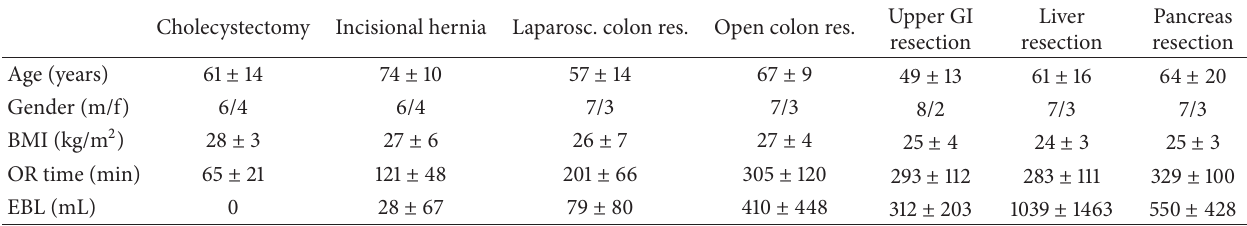
Table 1: Demographics and surgical details. Cholecystectomy Laparosc. colon res.